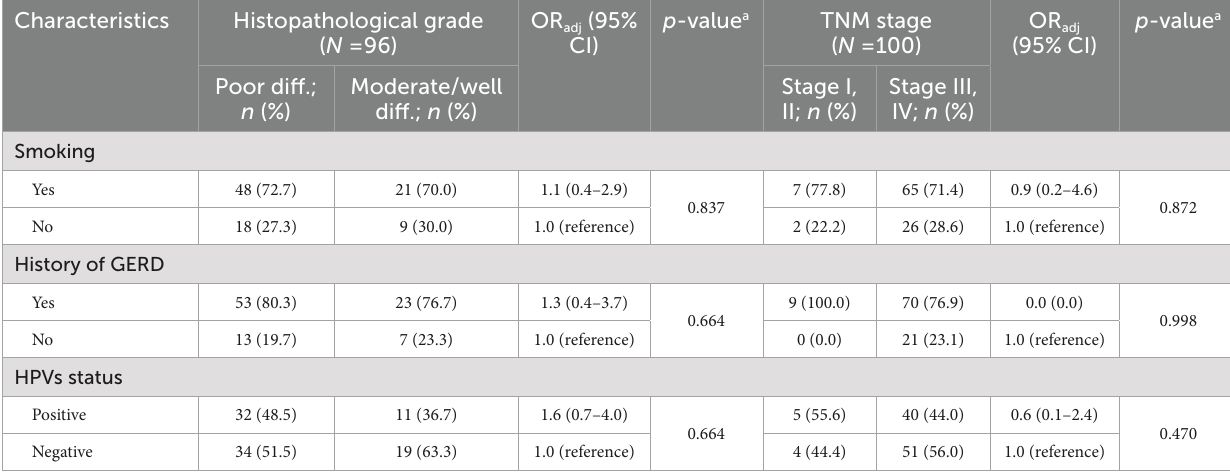
TABLE 6 Relationship of the potential risk factors and the prognostic features for